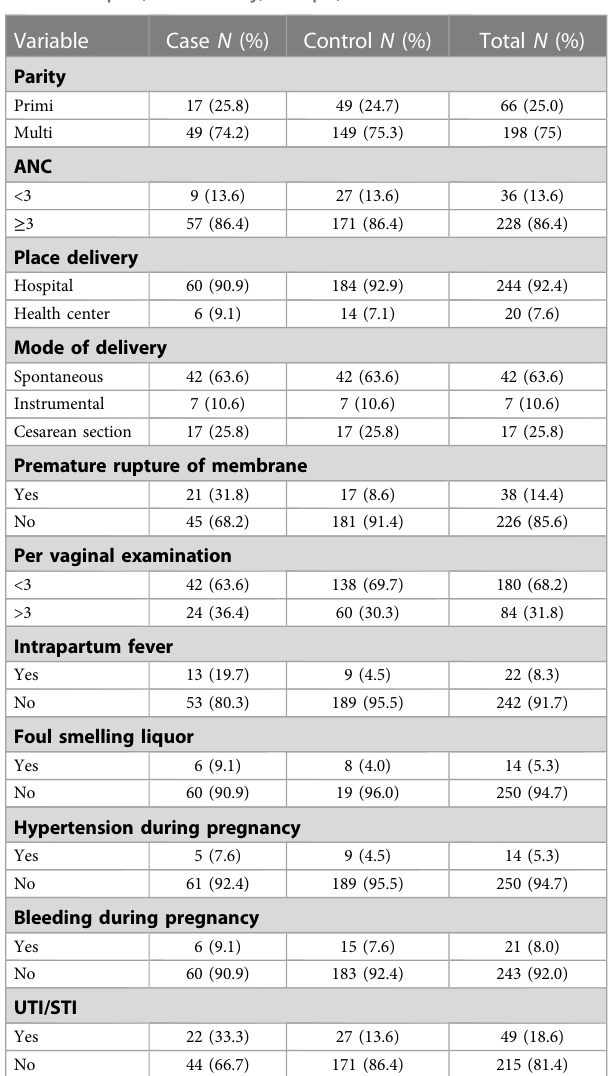
TABLE 3 Neonatal characteristics of cases and controls attending Hawassa University Comprehensive Specialized Hospital and Adare General Hospital, Hawassa city, Ethiopia,